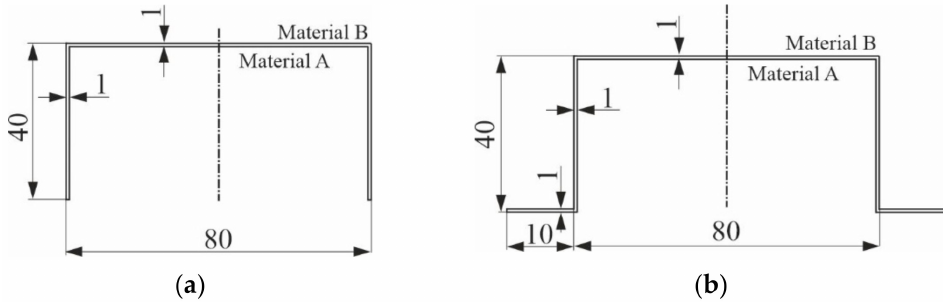
Figure 1. Cross-sections of the hybrid columns under analysis and their dimensions in millimeters: C-section ( a ) and TH-section ( b